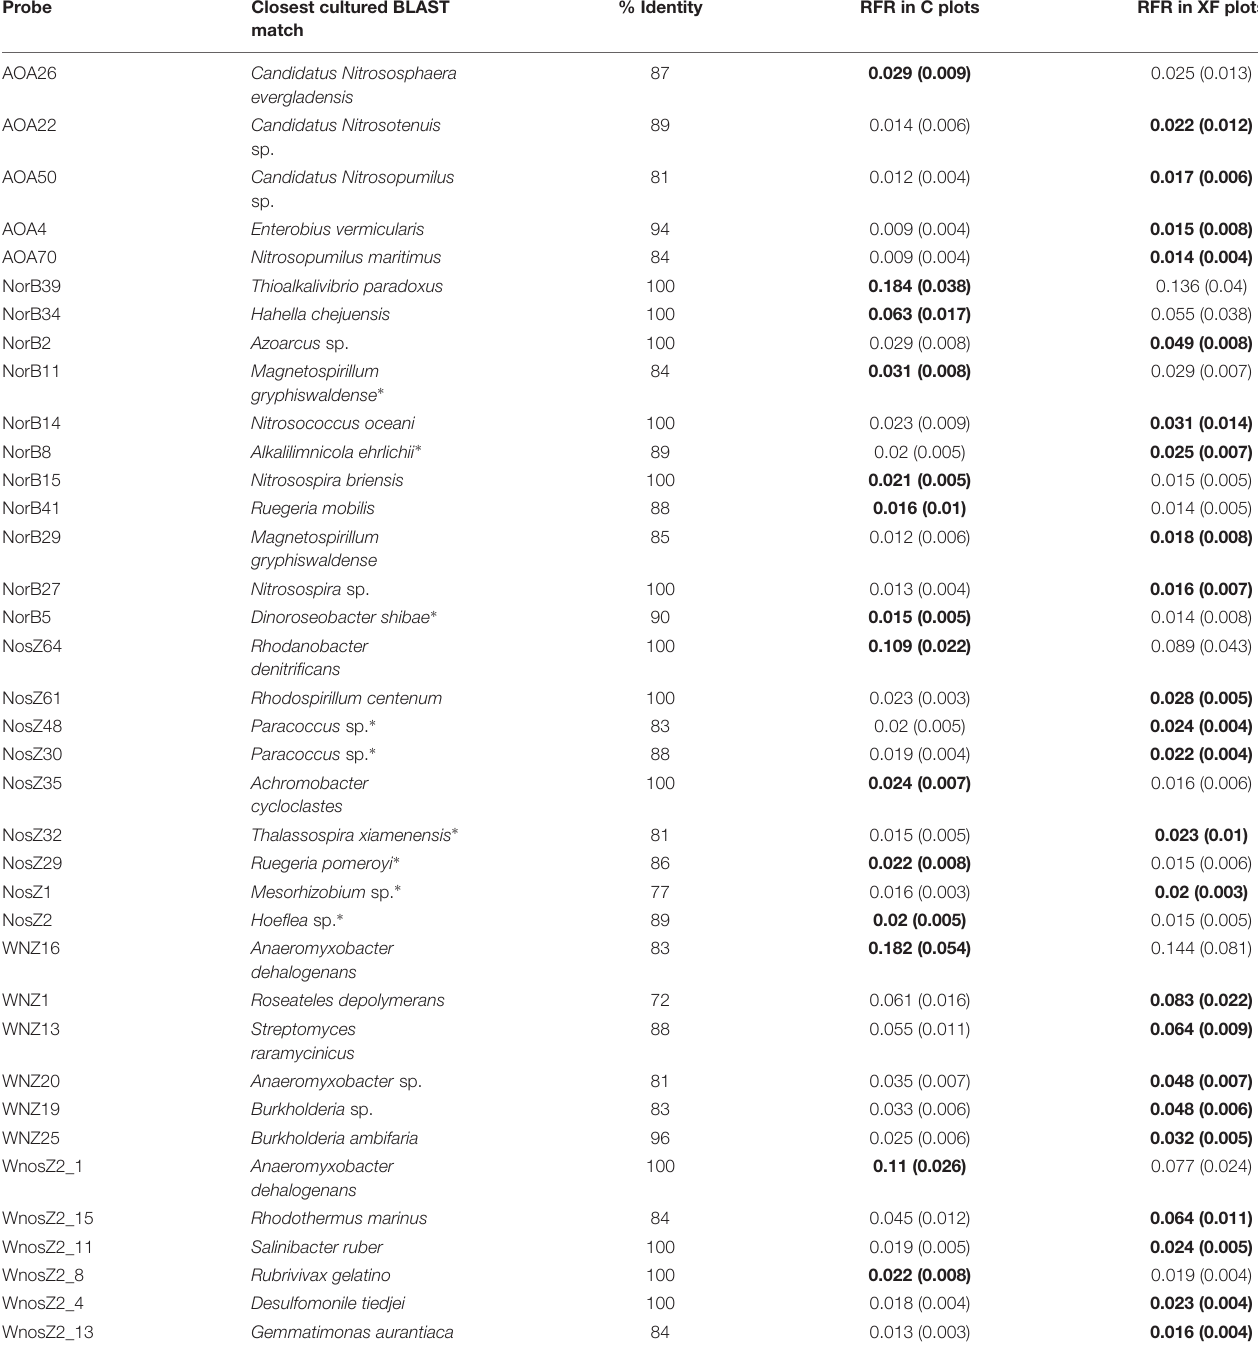
TABLE 1 | Closest cultured BLAST match, percent identity, and the average relative fluorescence ratio (RFR) per habitat for each archetype that accounted for greater than 1% of the total fluorescence and was significantly different among treatments by Kruskal–Wallis H-test and a significance threshold of p < 0.05. Probe Closest cultured BLAST % Identity RFR in C plots RFR in XF match